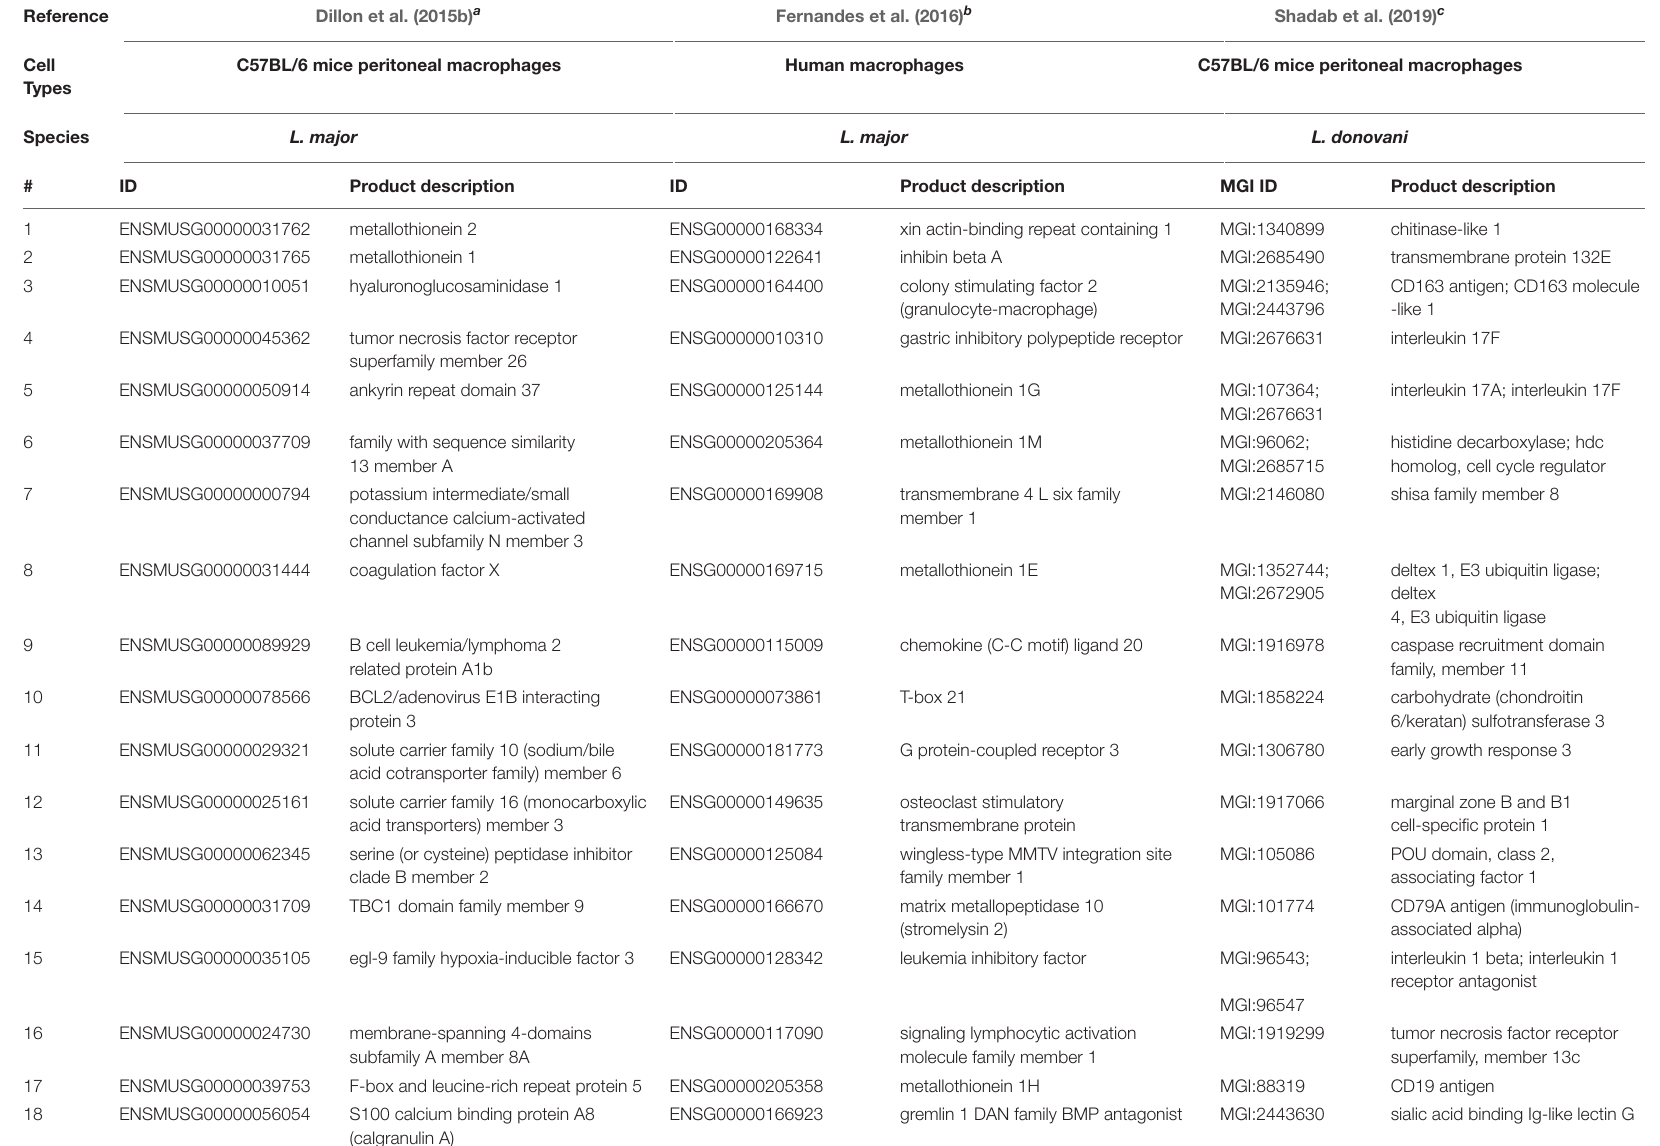
TABLE 3 | Top twenty upregulated genes in macrophages following infection with various Leishmania species.